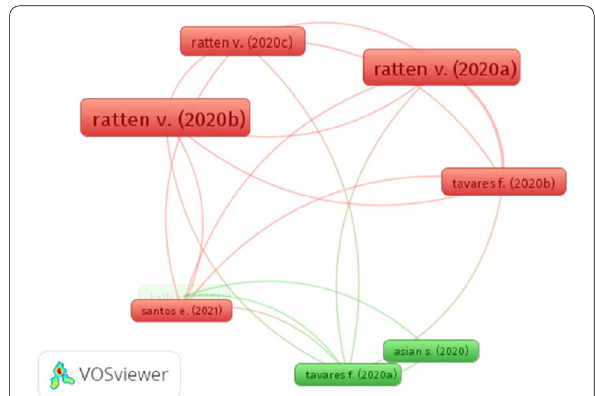
Fig. 6 Network visualization of the bibliographic coupling of